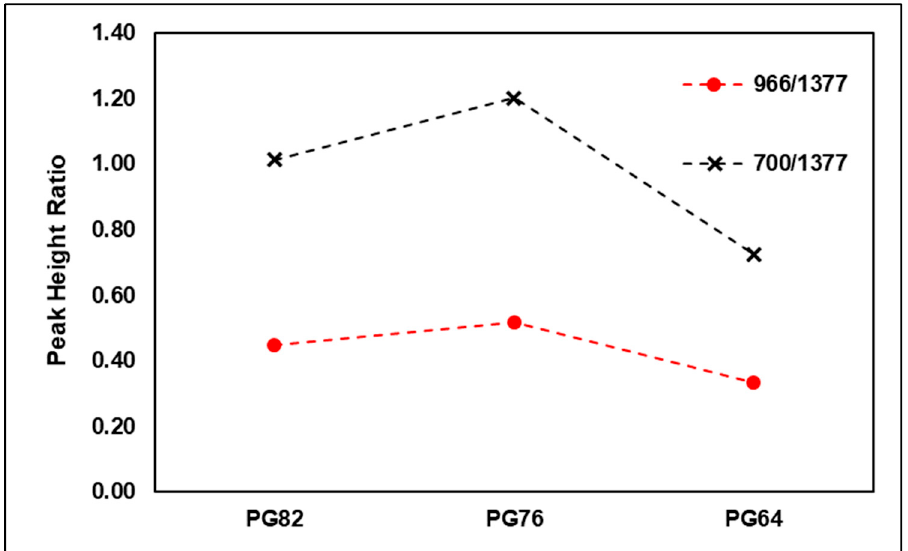
Figure 11. Peak height ratio by PG grade.